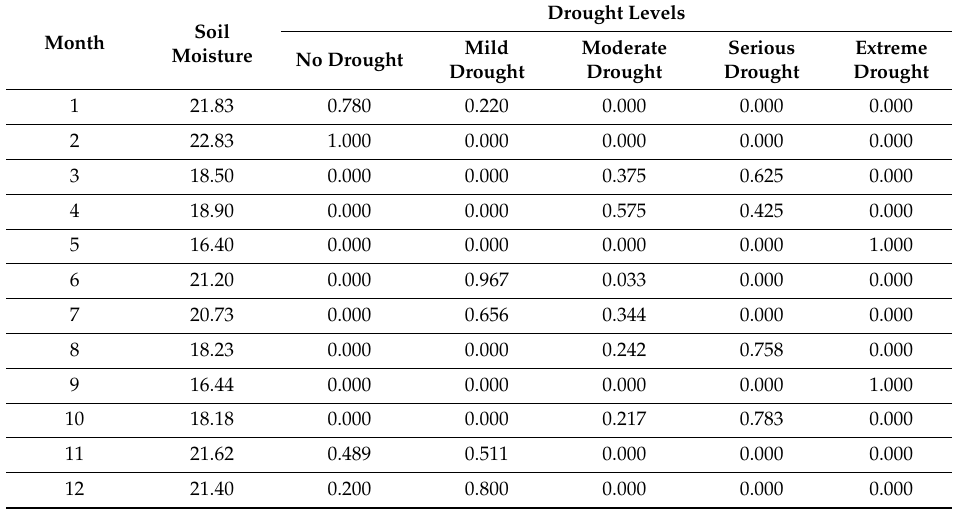
Table 10. Monthly soil moisture membership degree for the Jinghui Channel Irrigation Area in